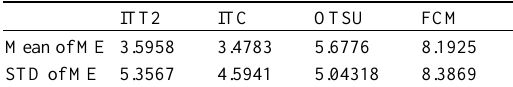
Table 6. The statistic of the ME values.